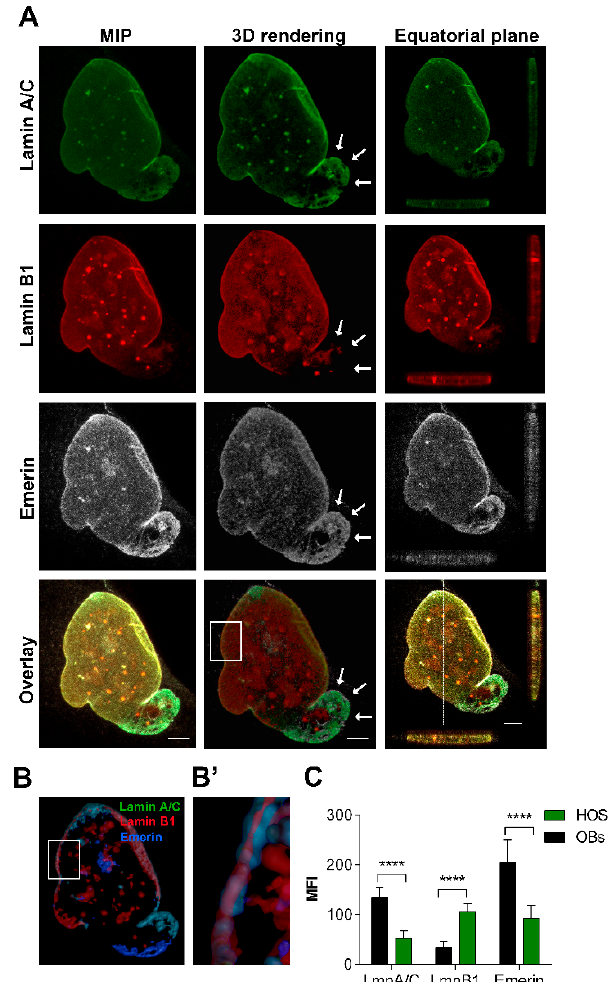
Figure 5. Behaviour of lamins and emerin, and nuclear morphology in HOS cell line. ( A ) Maximum intensity projection (MIP) of series of z-stacks images covering the entire nucleus (left column), 3D rendering in blend volume mode (central column, LAS X 3D software, Leica Microsystems, Wetzlar, Germany), and XZ- and YZ-axes projections performed in the central focal plane of the nucleus (right column) are shown. Bars: 5 µ m. Lamin A / C (red) decreased and emerin (white) was mildly polymerized and interdispersed around the nuclear rim and in the cytoplasm. ( B ) 3D rendering in the focal central plans of the nuclear rim in surface volume mode (Imaris software). Bar: 3 µ m. ( B’ ) High magnification of the 3D rendering of the boxed area showing the di ff erential expression of lamins (in green and red ) and emerin (pseudocoloured in blue). Bar: 1 µ m. ( C ) Mean Fluorescence Intensity (MFI) of lamins and emerin immunoexpression in HOS cells, in comparison to normal OBs. ****: p < 0.001.